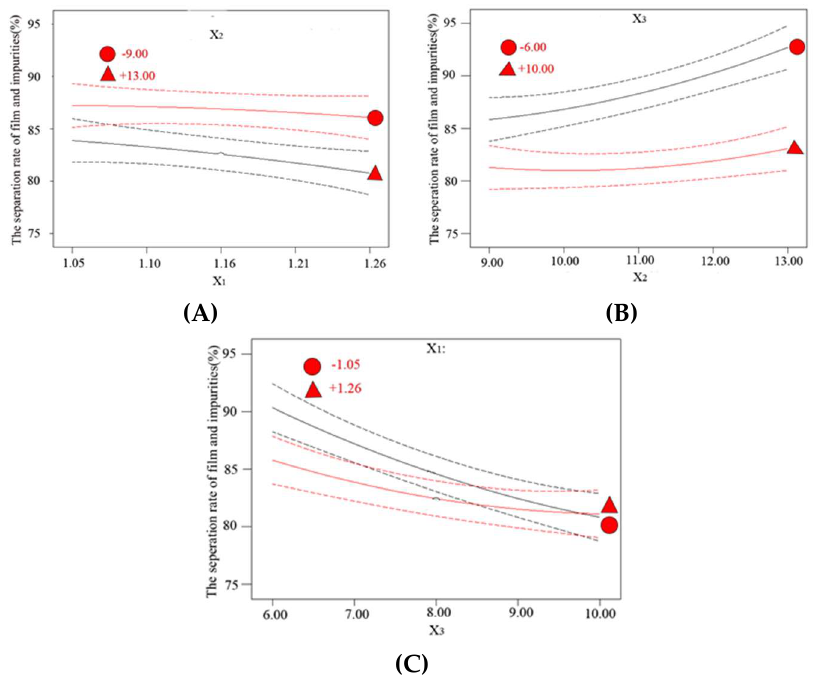
Figure 6. ( A ) The interaction between X 1 and X 2 . ( B ) The interaction between X 2 and X 3 . ( C ) The interaction between X 1 and X 3 .